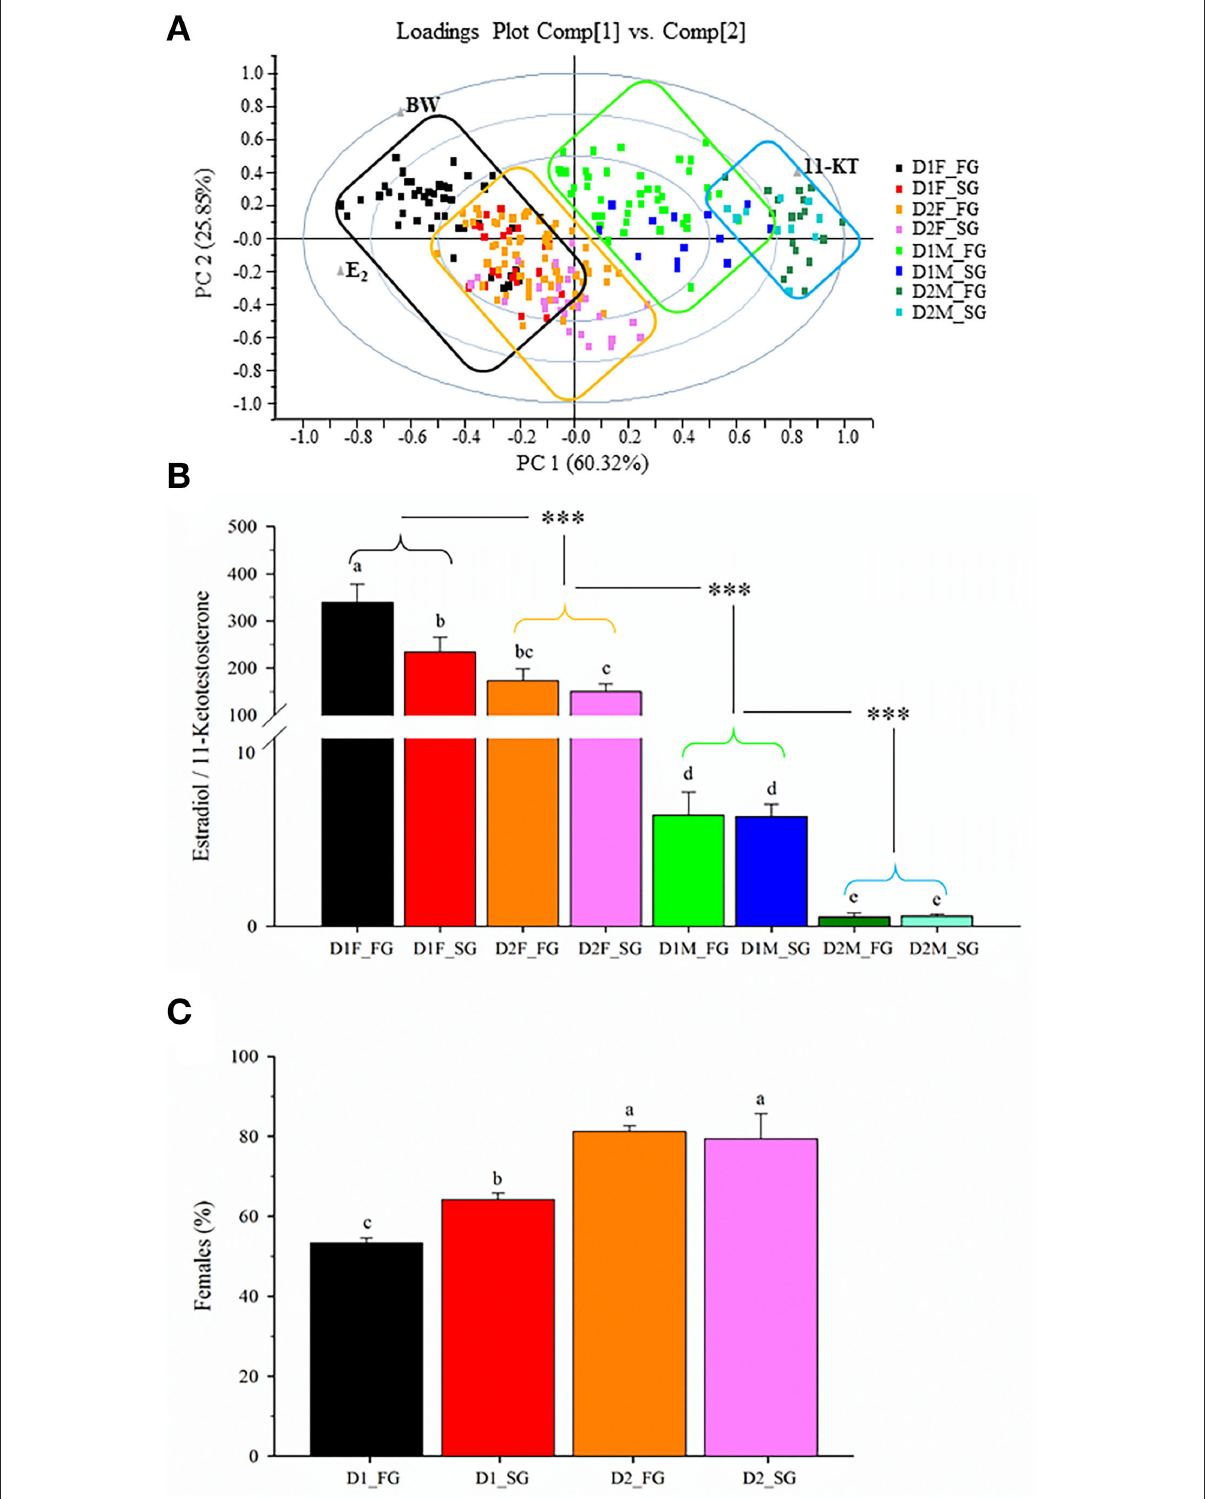
FIGURE6 (A) Principal component analysis of body weight and plasma sex steroids levels during the second spawning period (3-year-old fish). (B) Sex steroids quotient of females (F) and males (M) of each dietary group (D1–D2), and fast (FG) or slow (SG) growth family groups. Values are the mean ± SEM of the E 2 /11-KT quotient. Different letters indicate significant differences between each group. Asterisks indicate significant differences between males and female groups with different dietary regimes (Holm-Sidak post-hoc test, *** P < 0.001). (C) Female percentage of fast and slow growth family